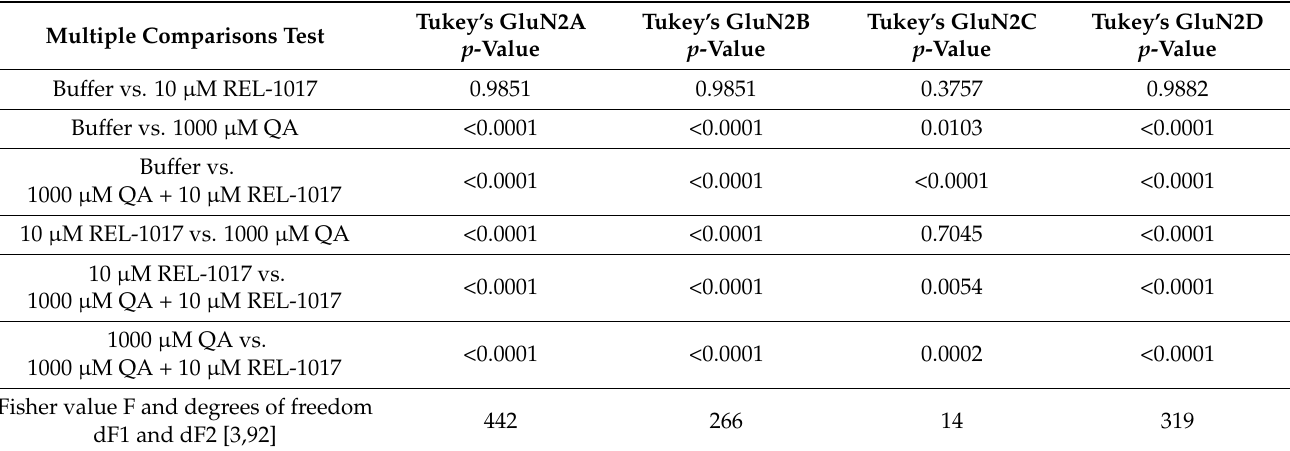
Table 1. Statistical significance of values reported in Figure